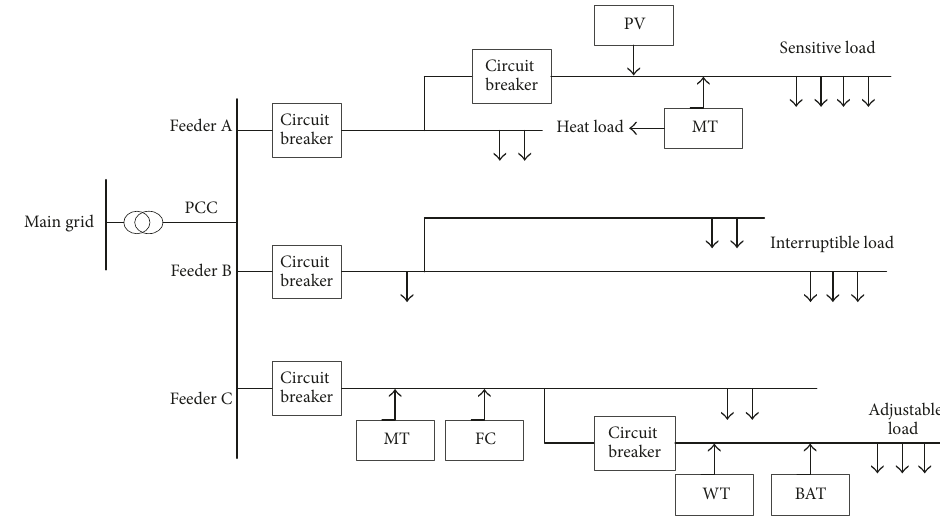
Figure 1: The structure of a typical